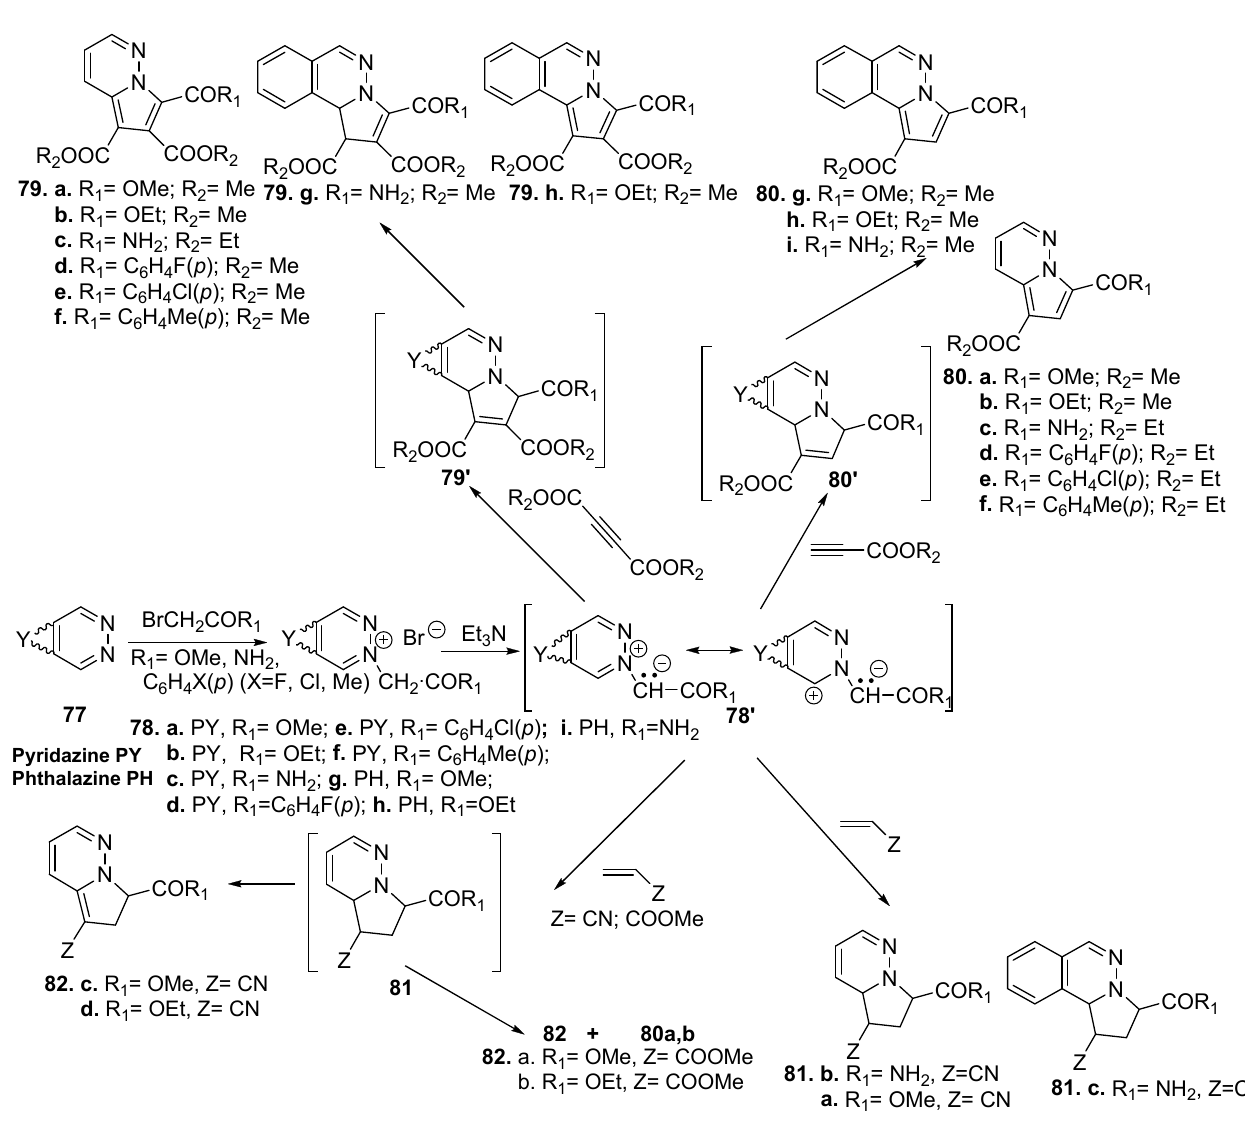
Scheme 23. Synthesis of fluorescent pyrrolodiazines 79–82 by 1,3-dipolar cycloaddition.